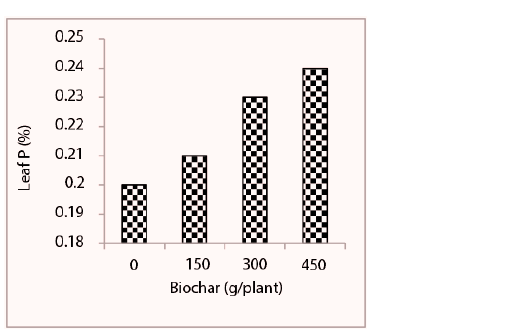
Mean values with the same letters are not significantly different at p ≤ 0.05 according to LSD test.